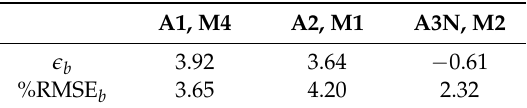
Table 2. Values of (cid:101) b and %RMSE b for the entire period.